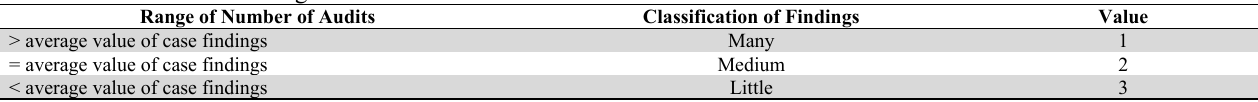
Classification of Audit